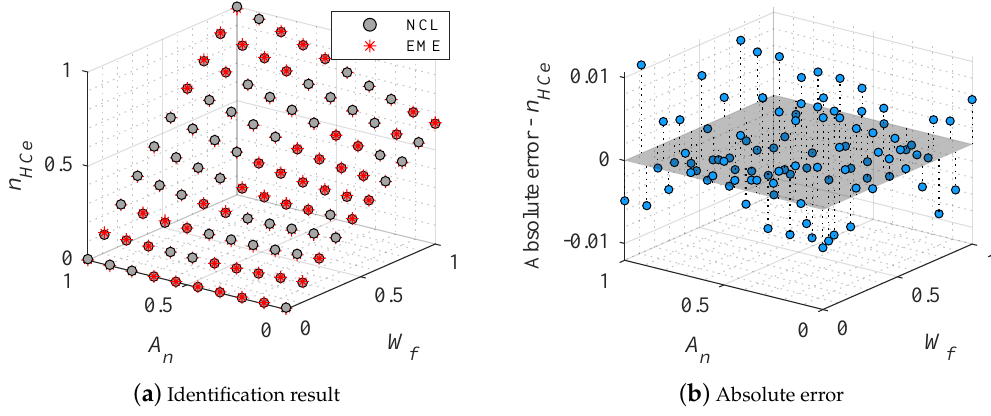
(cid:16) (cid:105) ) n α = [ W f , A n HCe .